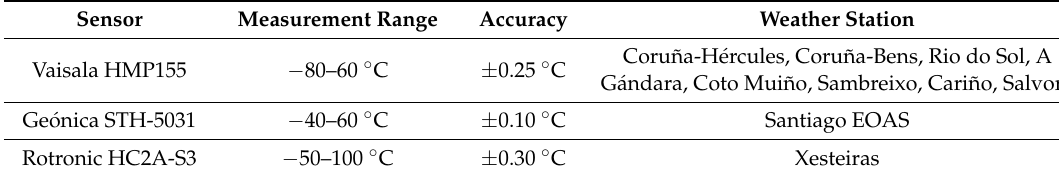
Table 4. Temperature and humidity sensors of each weather station.